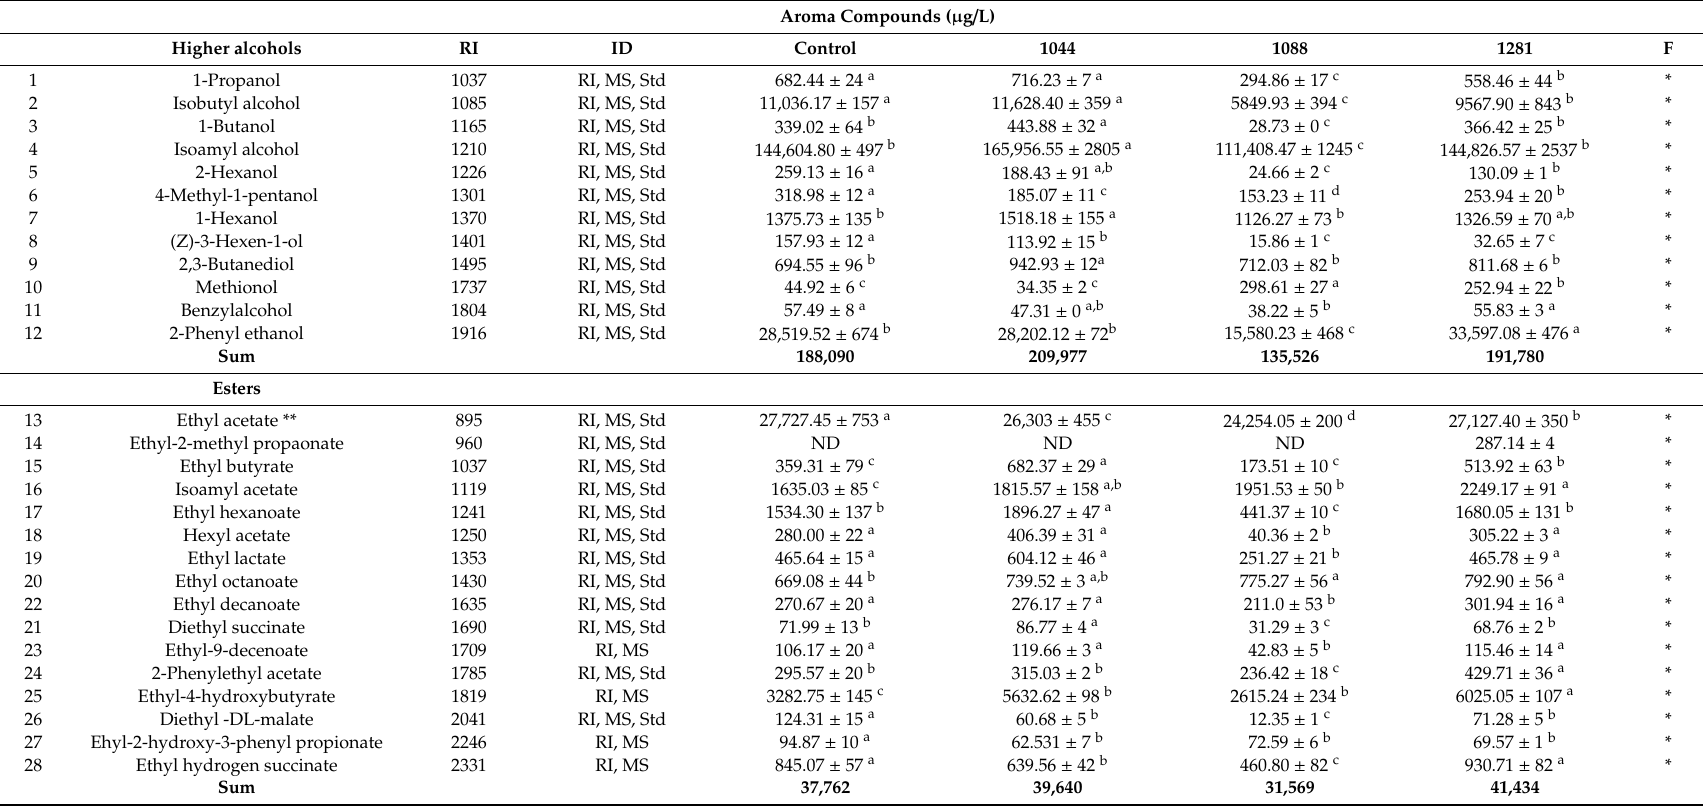
Table 3. Aroma composition of Narince wines produced with di ff erent S. cerevisiae yeast